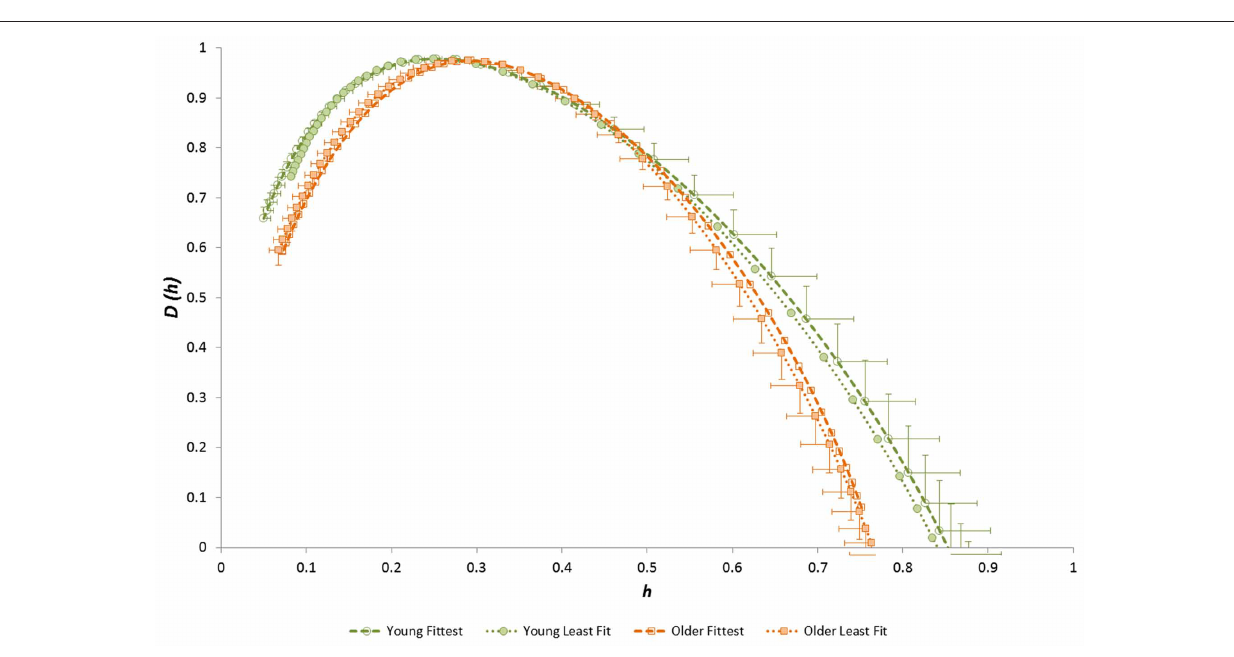
FIGURE 9 | Singularity multifractal spectra for younger and older groups after separation by fitness level (shown for the Evening period; other time periods showed similar